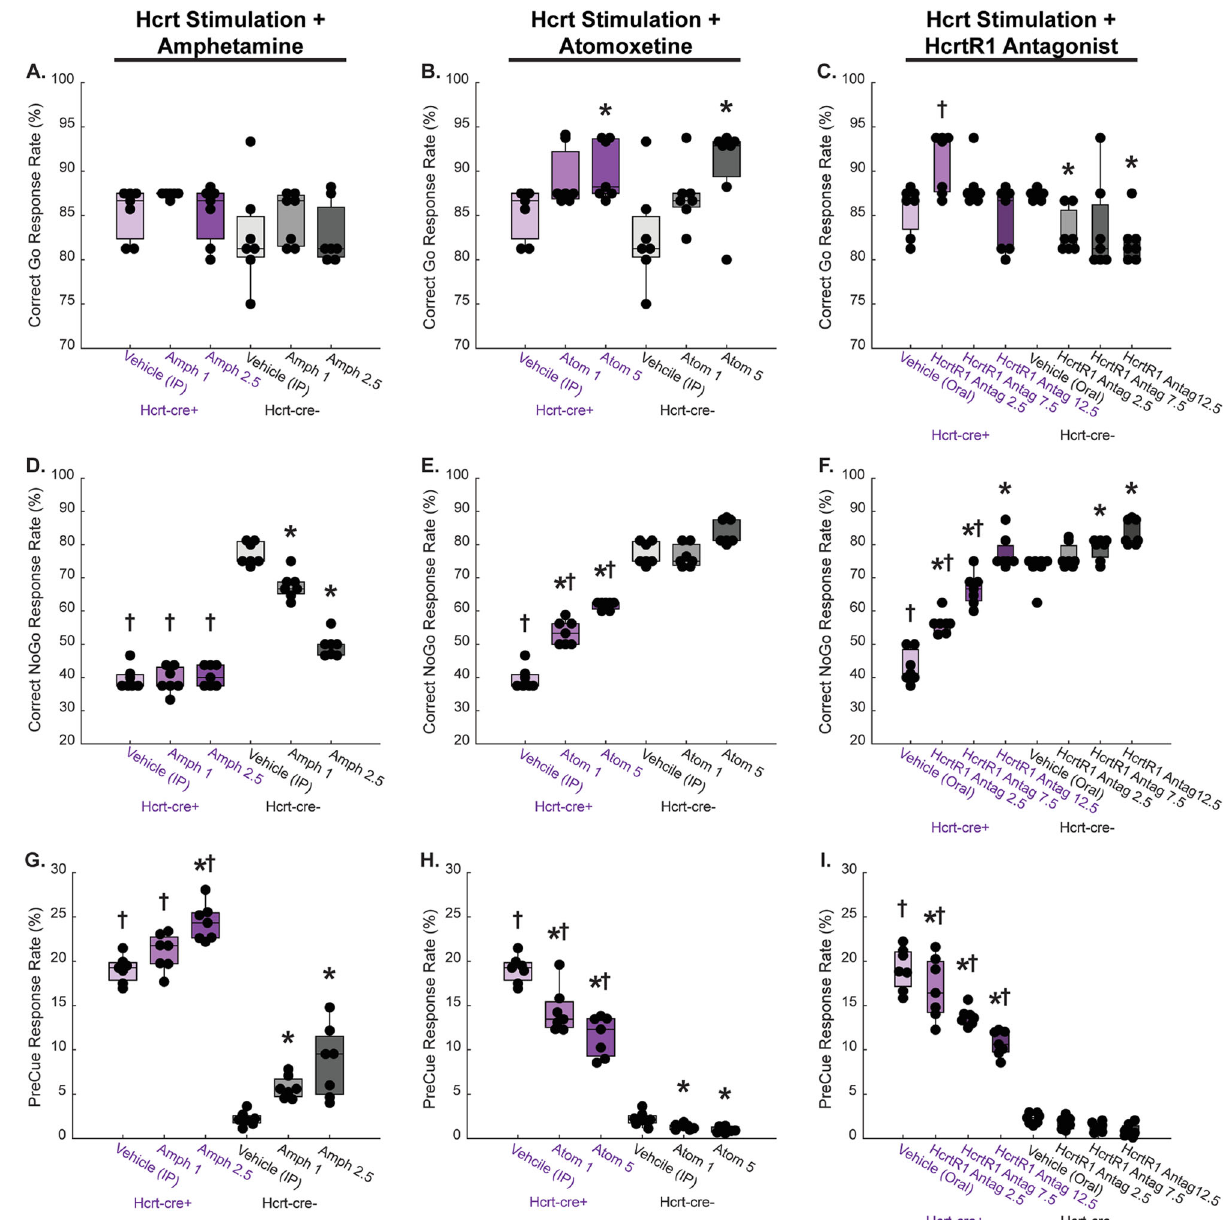
Fig. 4 Pharmacology of Hcrt-induced premature responses. The effects of 10 Hz Hcrt stimulation concurrent with administration of amphetamine ( A , D , G ), atomoxetine ( B , E , H ), or HcrtR1 antagonist ( C , F , I ) at various dosages on correct Go response rate ( A , B , C , stimulation delivered during the fi rst 5 s of the Go Cue Period), correct NoGo response rate ( D , E , F , stimulation delivered during the fi rst 5 s of the NoGo Cue Period), and PreCue response rate ( G , H , I , stimulation delivered during the last 5 s of the PreCue Period) are shown. Color indicates genotype (purple for hcre-cre + and gray for controls) and shade indicates dosage (darker for higher dosages). Vehicle data are shared between amphetamine and atomoxetine groups (delivered I.P.), whereas HcrtR1 antagonist data are compared to vehicle delivered in the same modality (oral gavage). *denotes difference from vehicle within same genotype (Bonferroni ’ s test, p < 0.05); † denotes difference from Hcrt-cre- controls at that particular dosage (Bonferroni ’ s test, p <